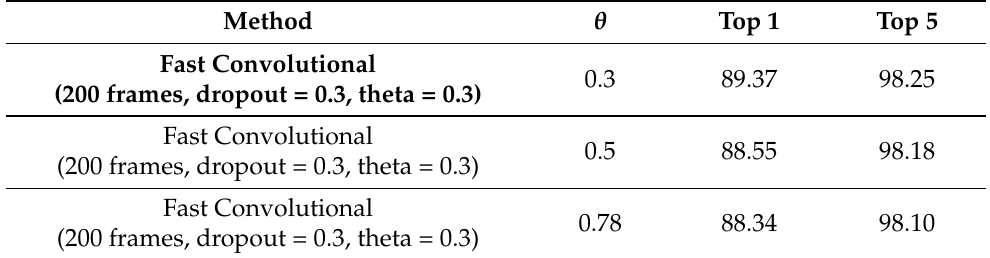
Table 1. Performances obtained depending on the interval used to choose the random angle for